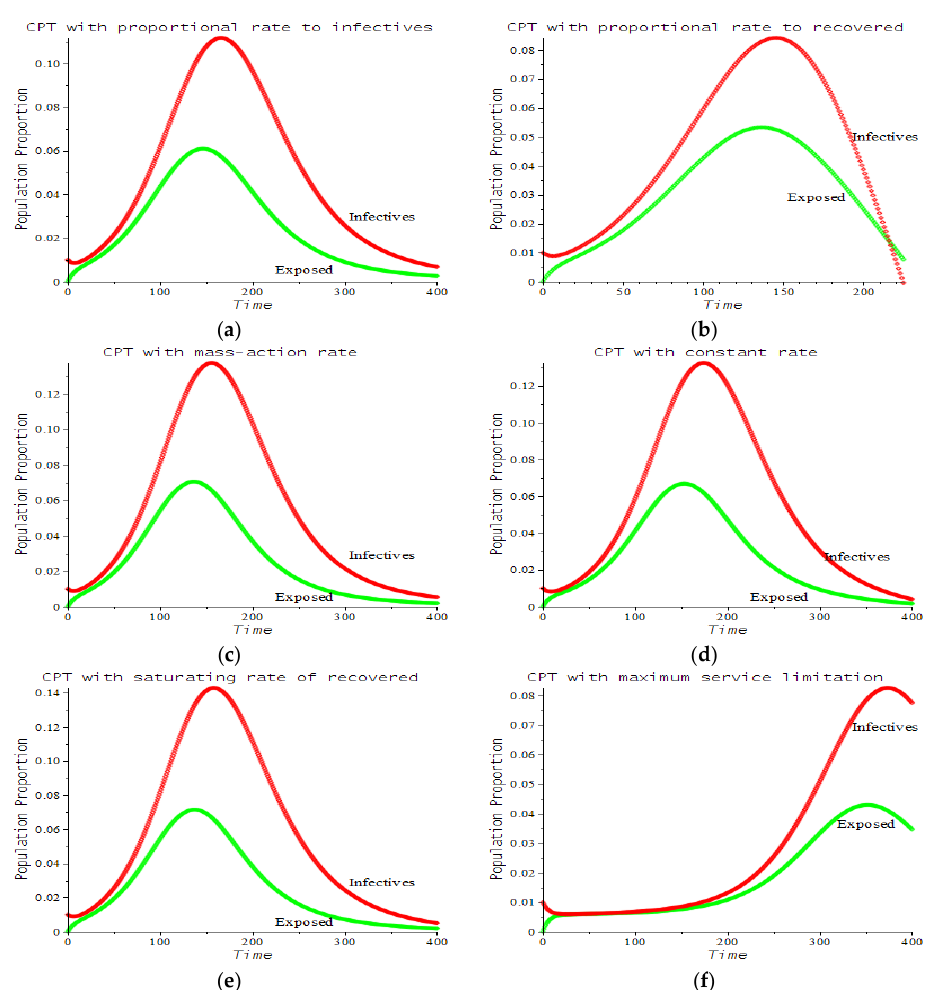
Figure 6. Graphs showing the effects of different rates of CPT on decreasing the number of infec- tives (i.e., lowering the height of the infective peaks) ( a , b ) and, consequently, increasing the num- ber of remaining susceptibles ( c , d ). The other parameters were the same as in Figure 2.